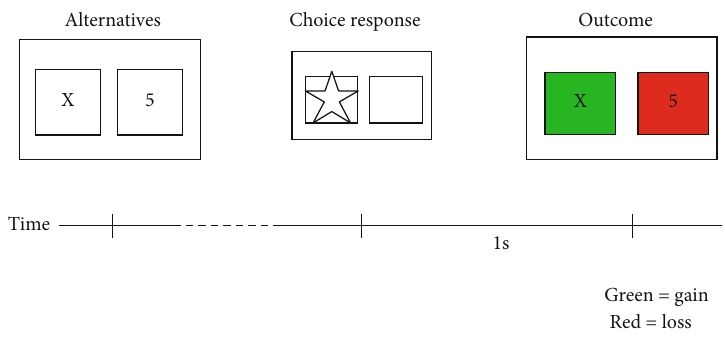
Figure 2: The experiments of game